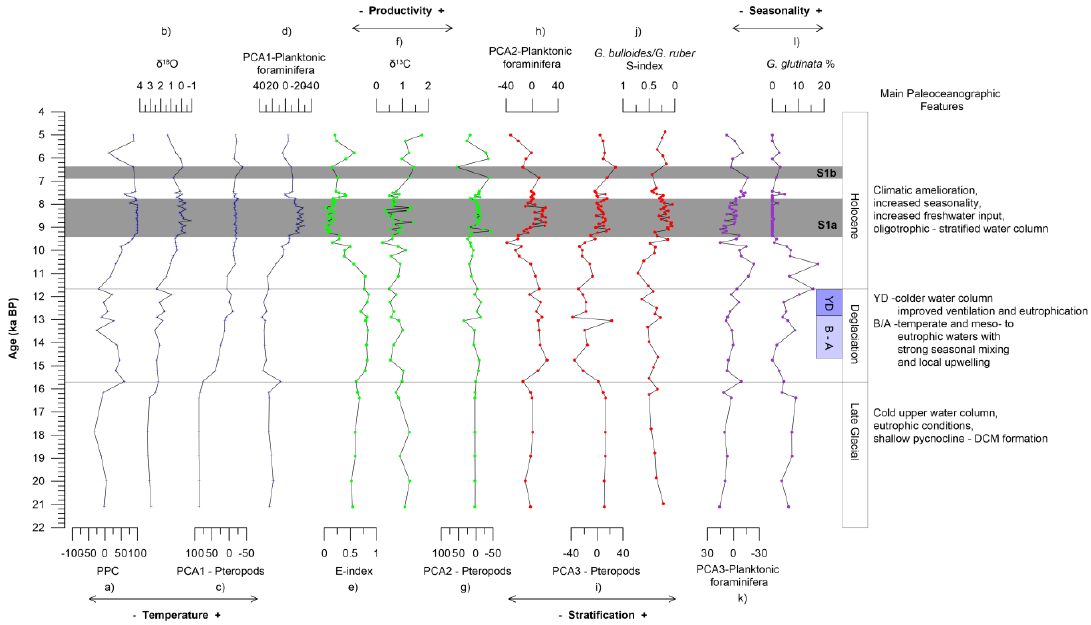
Figure 6. Comparison between down-core score plots of the factors revealed by PCA analysis, micropaleontological and geochemical results of core KIM-2A: ( a ) planktonic paleoclimatic curve (PPC); ( b ) oxygen isotope record ( δ 18 O G. ruber ); ( c ) factor 1 of planktonic foraminifera (PCA1; temperature factor); ( d ) factor 1 of pteropods (PCA1; temperature indicator); ( e ) eutrophication index (E-index); ( f ) carbon isotope record ( δ 13 C G. ruber ); ( g ) factor 2 of pteropods (PCA2; productivity factor); ( h ) factor 2 of planktonic foraminifera (PCA2; stratification factor); ( i ) factor 3 of pteropods (PCA3; stratification factor); ( j ) G. bulloides/G. ruber ratio (S-index); ( k ) factor 3 of planktonic foraminifera (PCA3; seasonality factor); and ( l ) G. glutinata %.